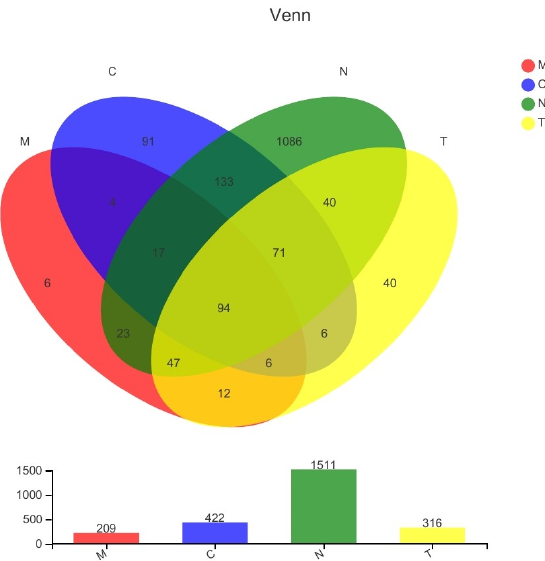
Figure 1. Venn diagram of bacterial species detected in samples collected from all four